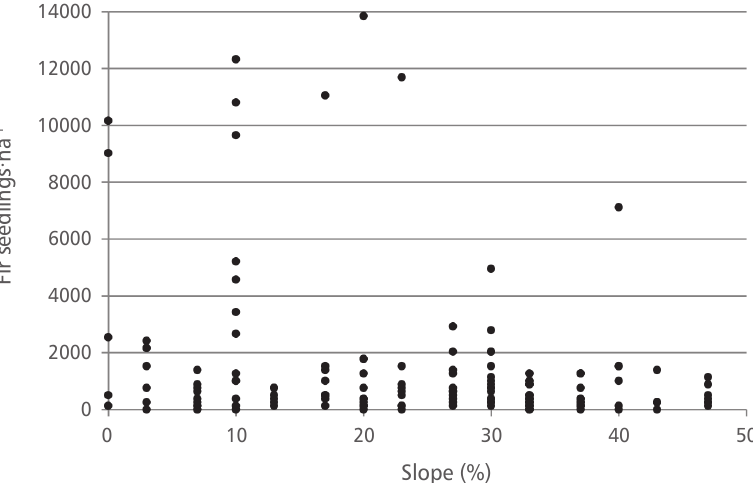
FIGURE 3. Fir seedling densities observed at different slope gradients. Dots represent individual values.